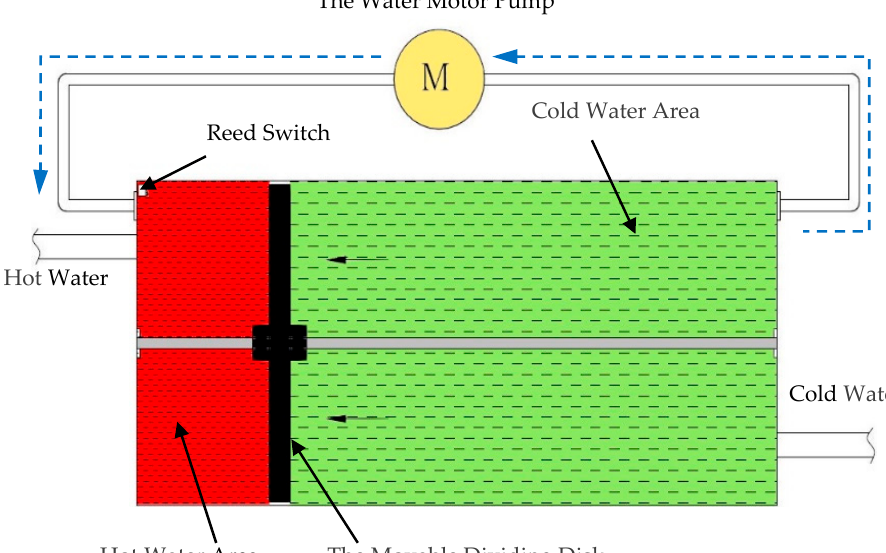
Figure 4. The 3rd generation solar water heating tank [20].